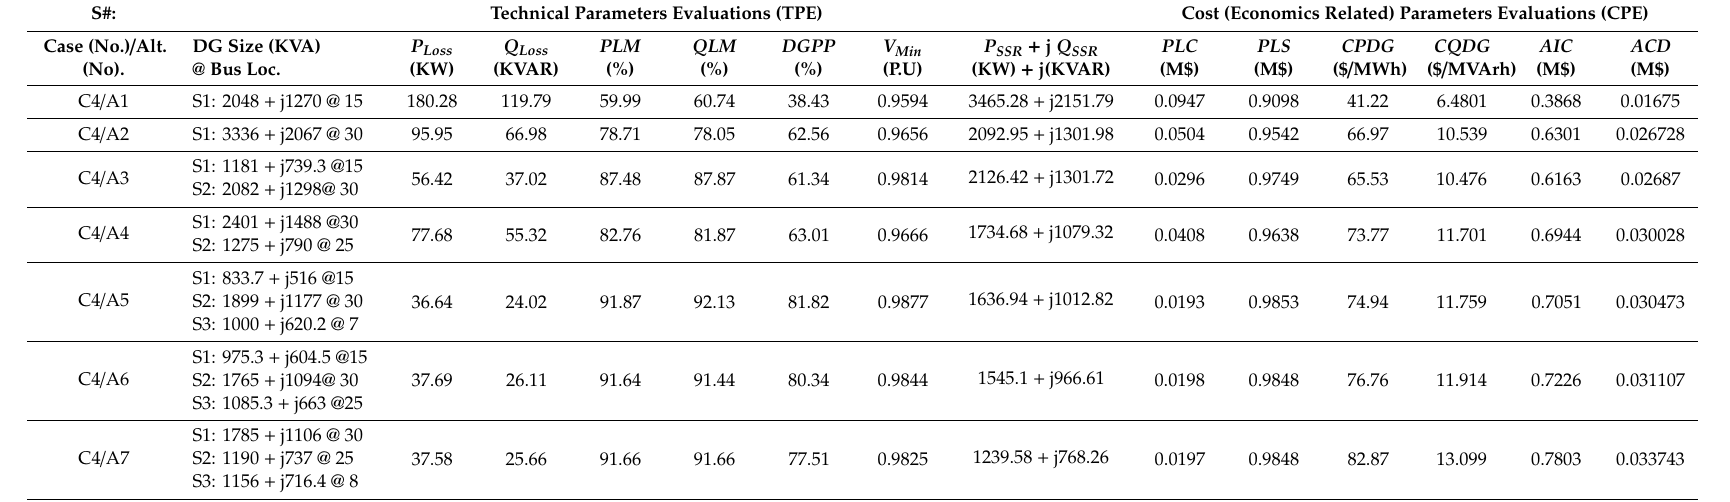
Table 27. Techno-economic evaluation analysis in case 4 (C4_OLG) for 33-bus